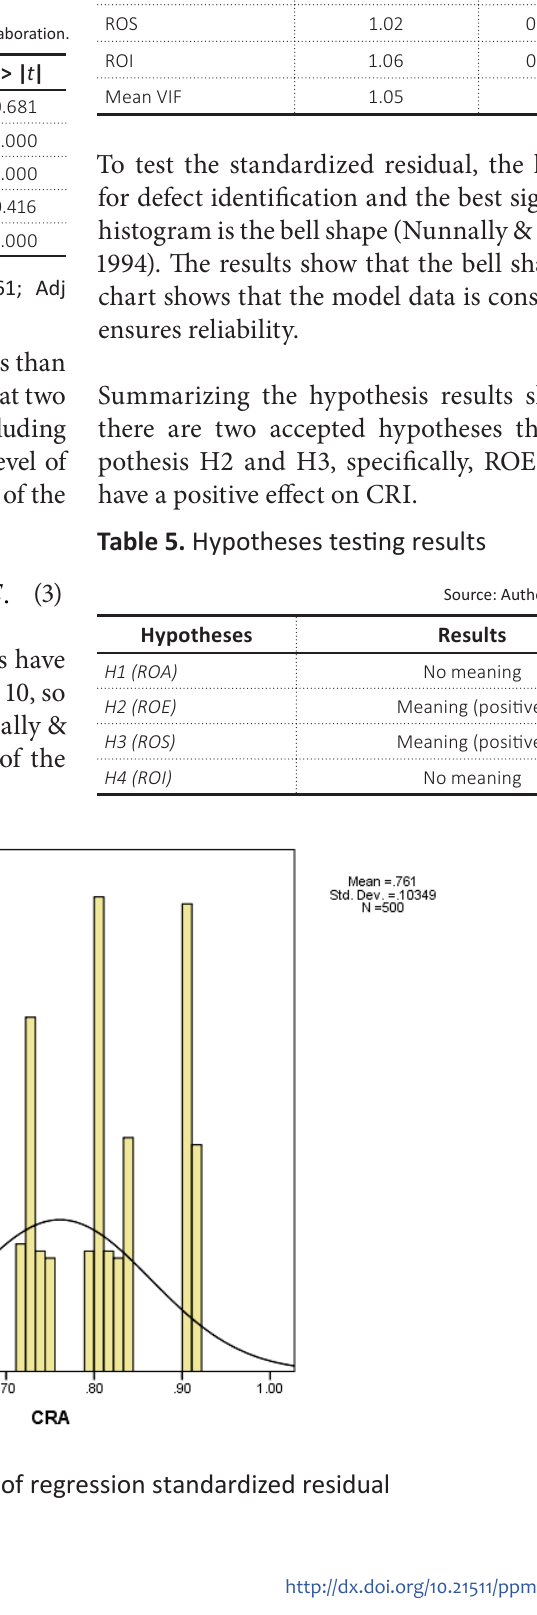
Table 3. Regression results